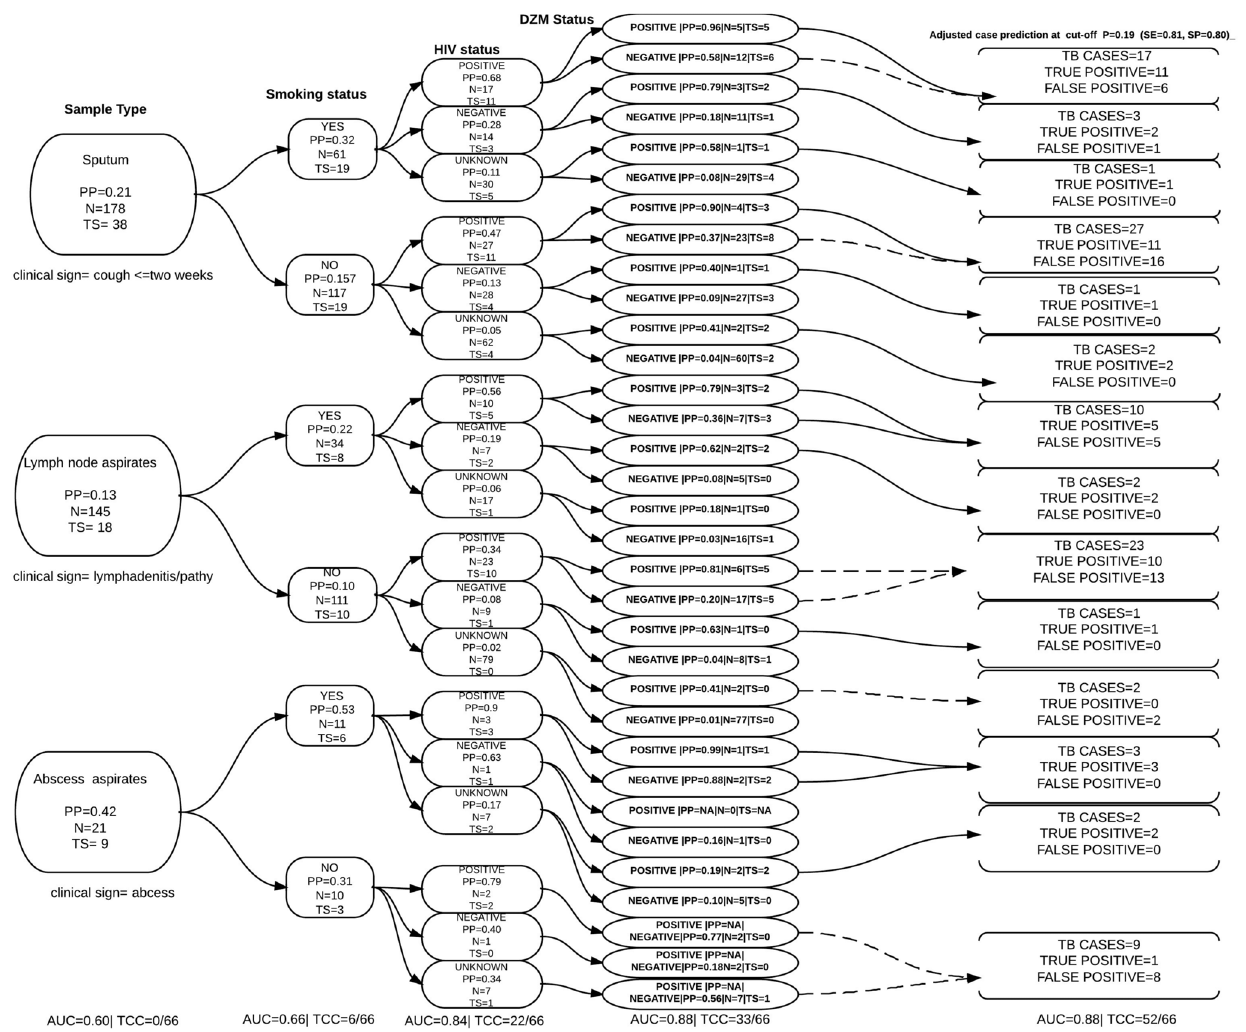
Figure 3. The diagnostic algorithm chart showing the case proportions formed by clinical and diagnostic combinations with data from Mubende regional referral hospital, AUC is the area under the curve, PP=predicted probability of being TB case, TS=total number of true TB cases in each covariate pattern based on the gold standard, N=the total number of individual in a specific covariate pattern (sub-population formed by combining clinical factors), TCC=total number of TB-cases accurately classified my the model. The adjusted case predictions are made at a probability cut off P=0.199 as established in figure 3, the broken lines shows pathways that are most likely to increase numbers of false positive